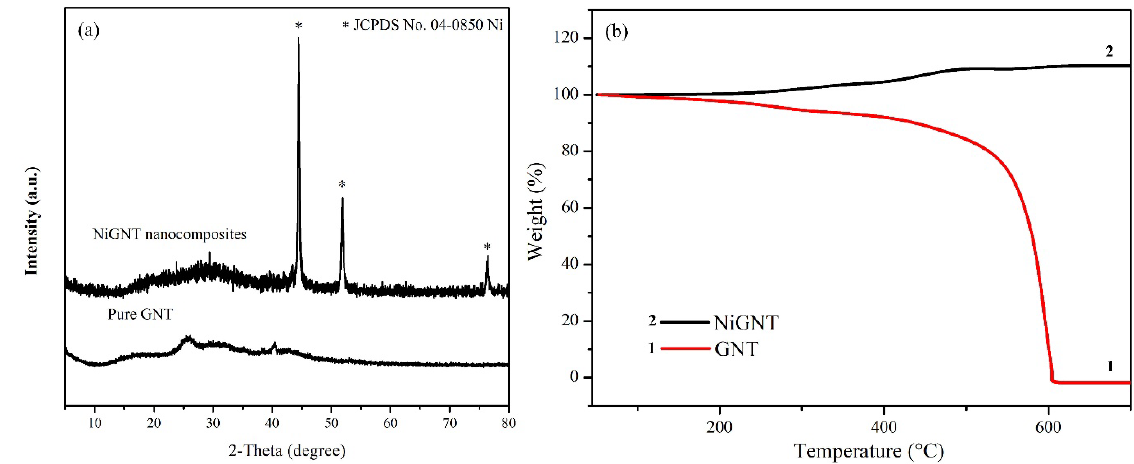
Figure 2. XRD patterns ( a ) and TGA results ( b ) of NiGNT and pure GNT